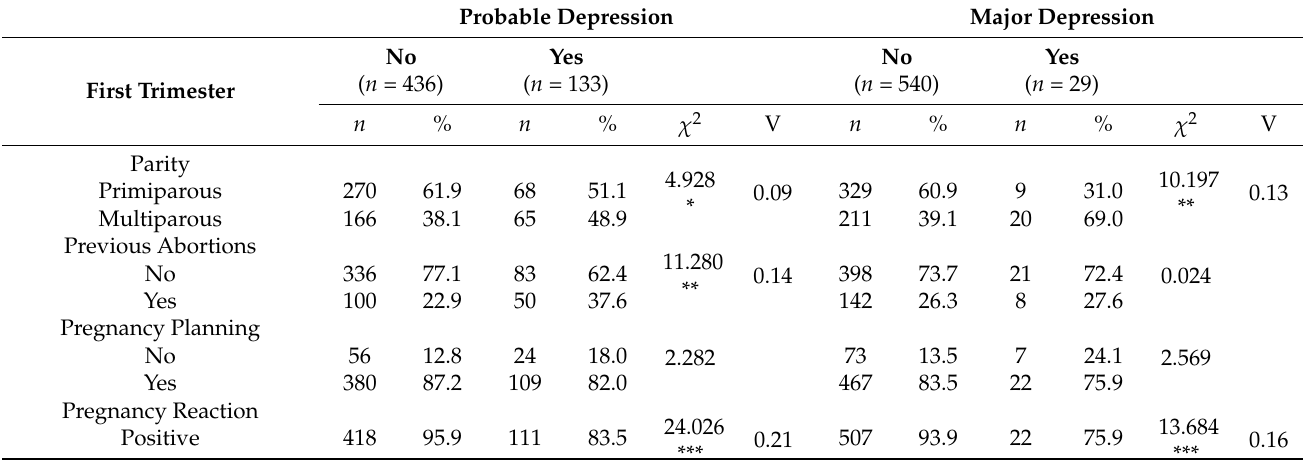
Table 2. Characteristics of women with probable depression and major depression as a function of pregnancy-related